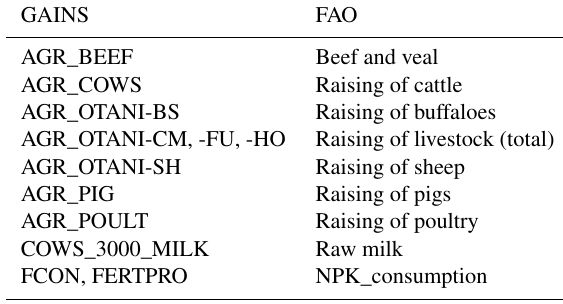
Table C3. Mapping from GAINS agricultural sectors to FAO activities. GAINS FAO